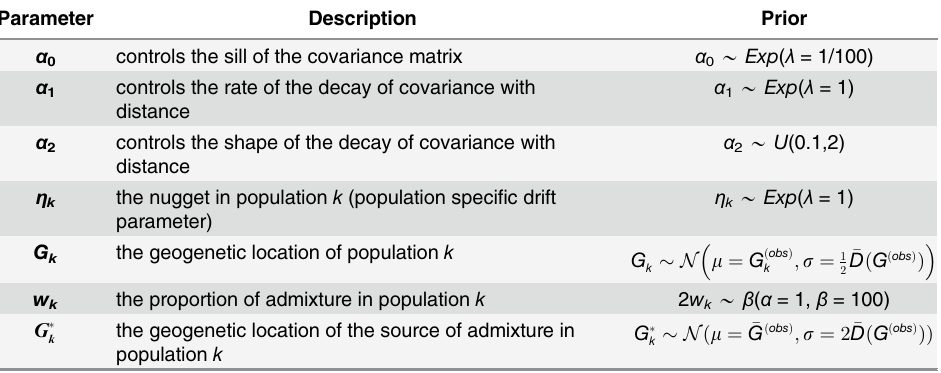
Table 2. List of parameters used in the SpaceMix models, along with their descriptions and priors. (cid:2) D ð G ð obs Þ Þ is the mean of the pairwise distances between observed locations G ( obs ) . Parameter Description Prior α